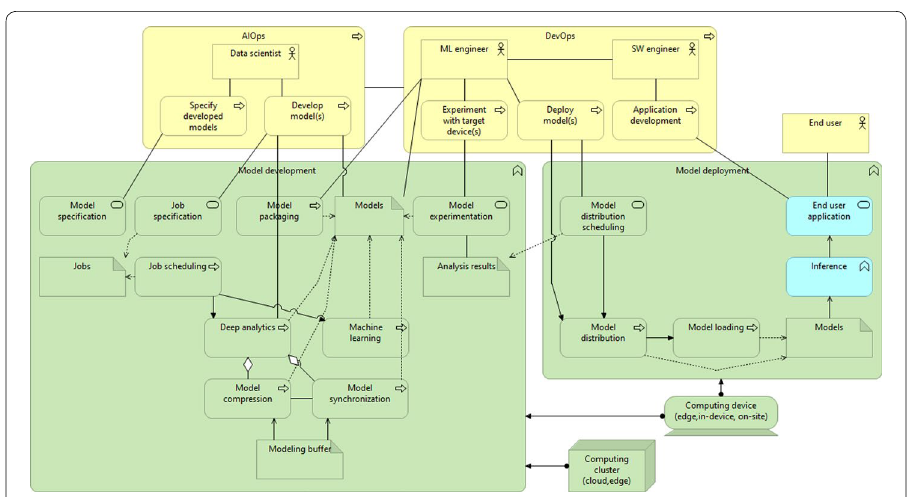
Fig. 5 Model development and deployment view to the big data